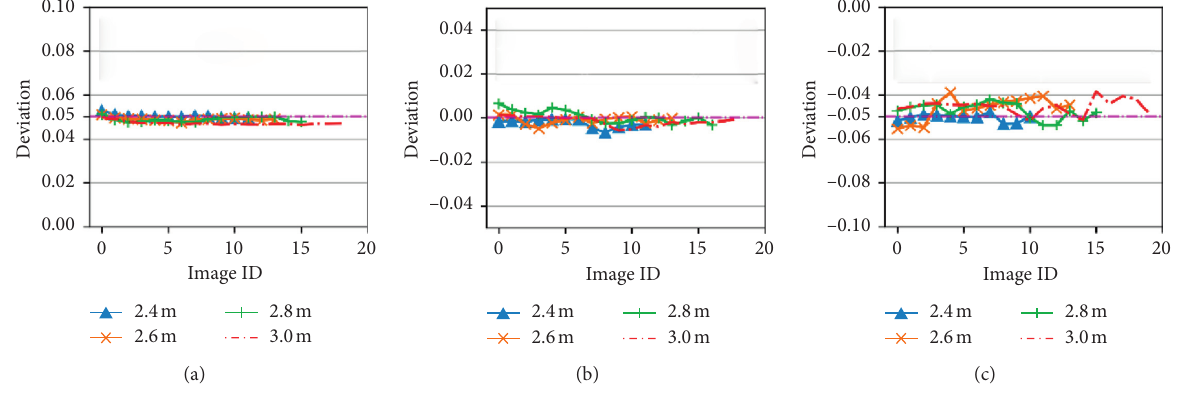
Figure 11: Estimated DDs at each standard DD and shooting height. (a) DD: +5%. (b) DD: 0%. (c) DD: − 5%. Table 5: Deviation detection results of the belt